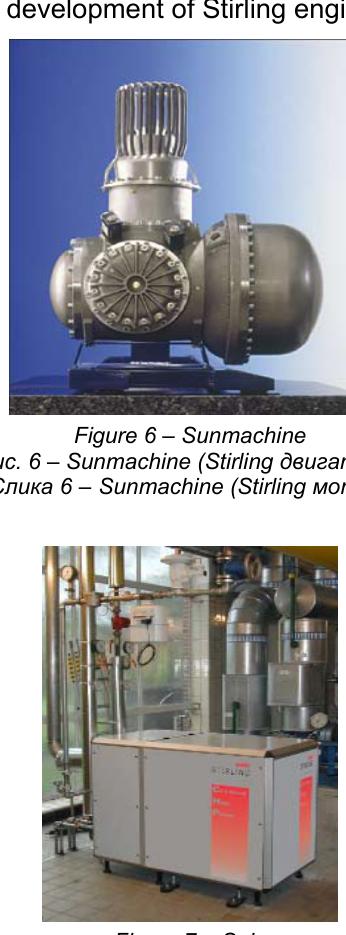
Рис . 7 – Solo (Stirling двигатель ) Слика 7 – Solo (Stirling мотор